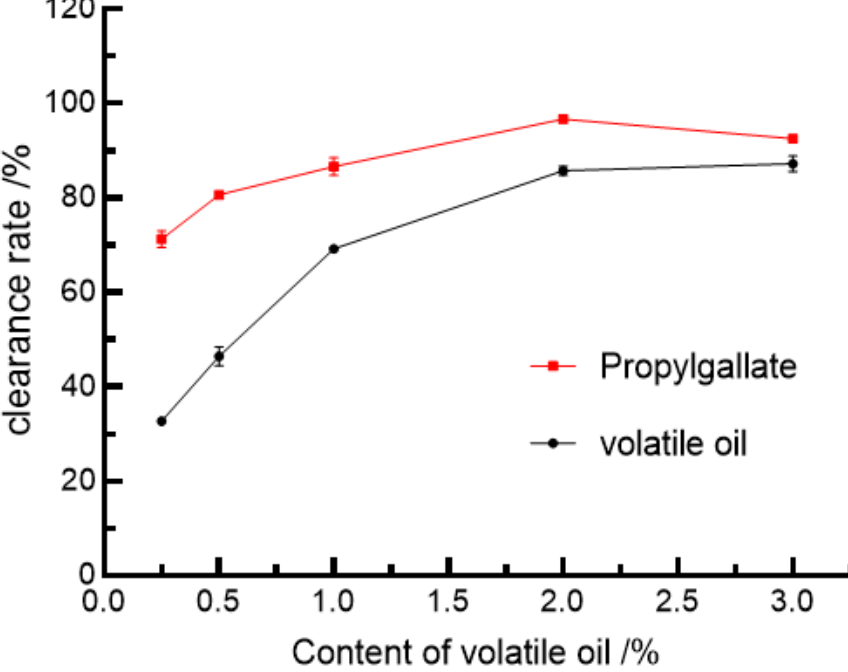
Figure 2. DPPH scavenging activity of Allium tenuissimum L. flowers essential oil.